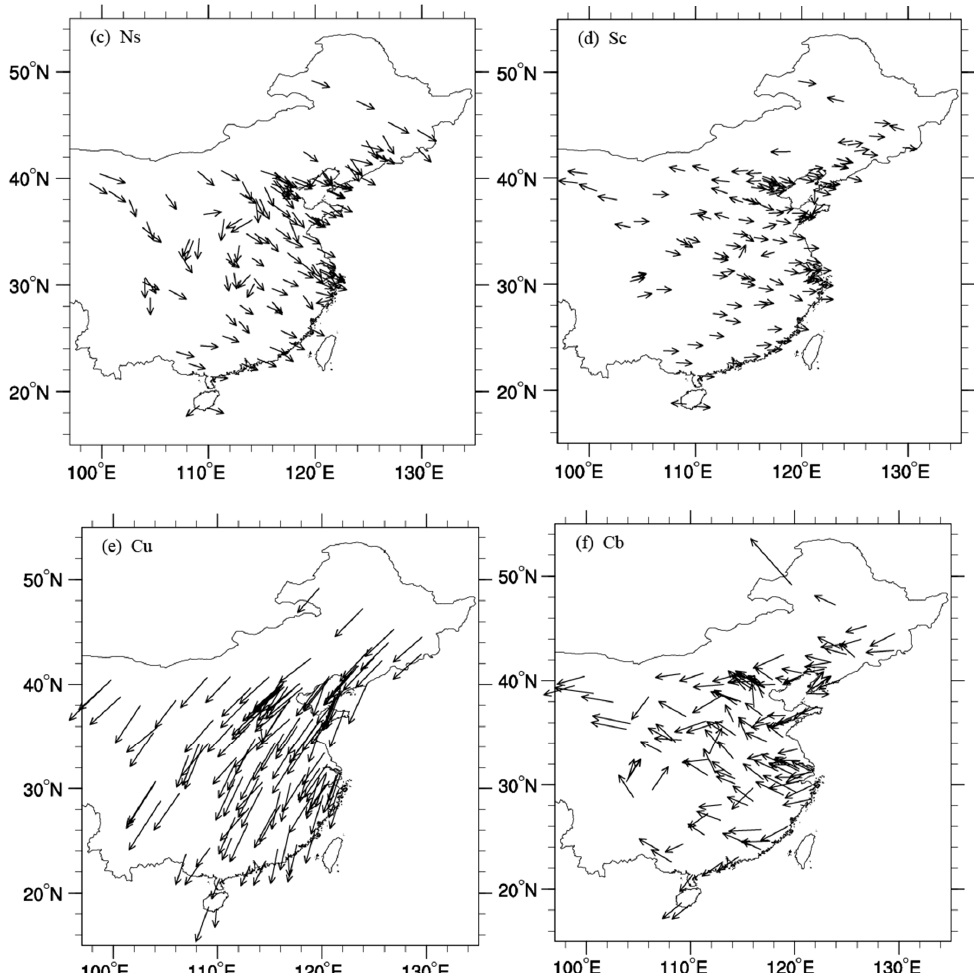
Figure 2. Spatial distributions of the phases and amplitudes of the diurnal cycles of various clouds: ( a ) TC, ( b ) Ci, ( c ) Ns, ( d ) Sc, ( e ) Cu, and ( f ) Cb. The directions of the vectors denote the local solar time (LST) of the maximum cloud occurrence frequency (phase clock in Figure 2b), while the length of the vectors represent the amplitude of the diurnal cycle, the reference arrow represents the amplitude of diurnal cycle is 1.0.